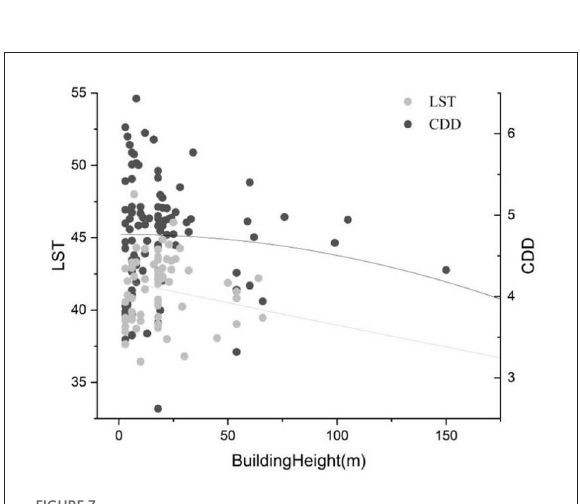
FIGURE7 Correlation between LST (CDD) and building height (CDD unit: ◦ C d).